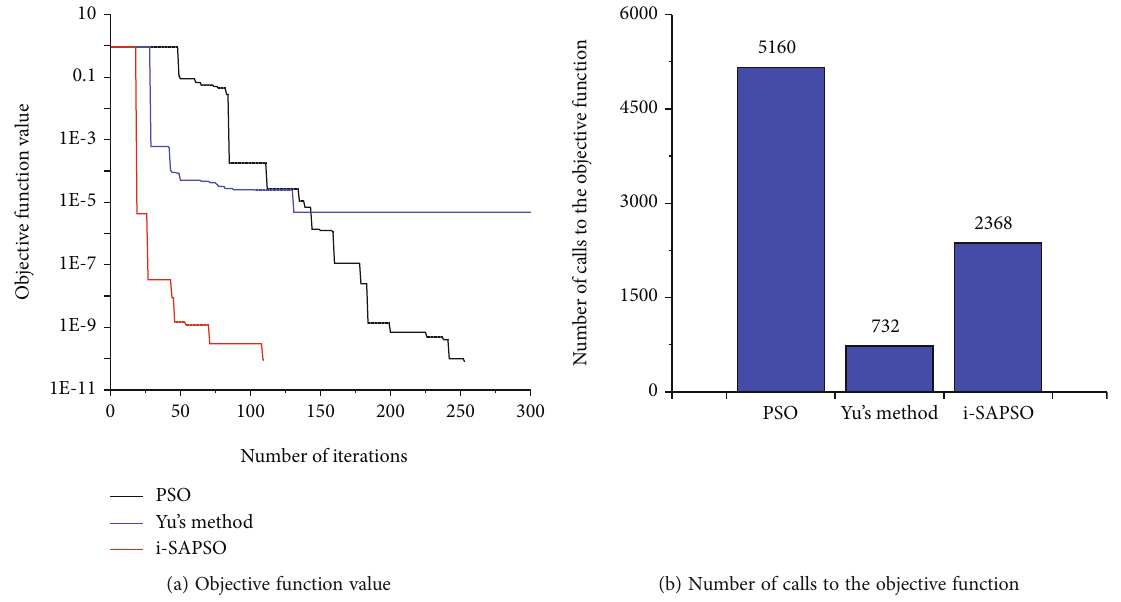
Figure 3: Performance comparison of di ff erent methods. Table 1: Optimized objective function values of di ff erent methods. PSO Yu ’ s